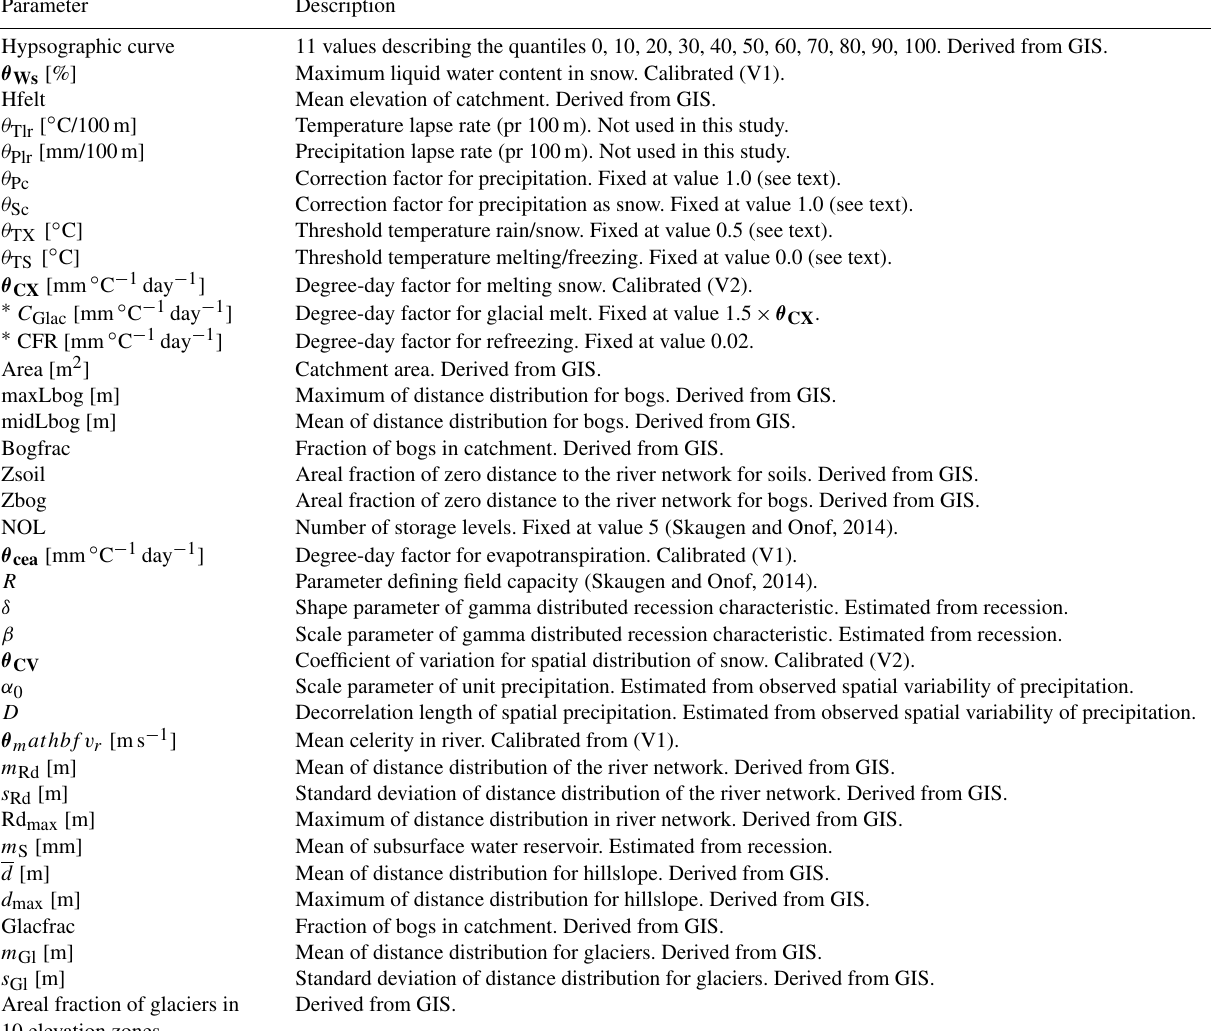
Table 1. Parameters of the DDD model with description and method of estimation. Some parameters (denoted with a ∗ ) have values obtained through experience in calibrating DDD for gauged catchments in Norway. These values are within the recommended range for the HBV model (Sælthun, 1996). Other parameter values are assigned standard values as suggested in the literature. The GIS analyses are carried out using the national 25 × 25m digital elevation model (http://www.statkart.no). Parameters in bold have been calibrated in this study, by either dataset V1 or